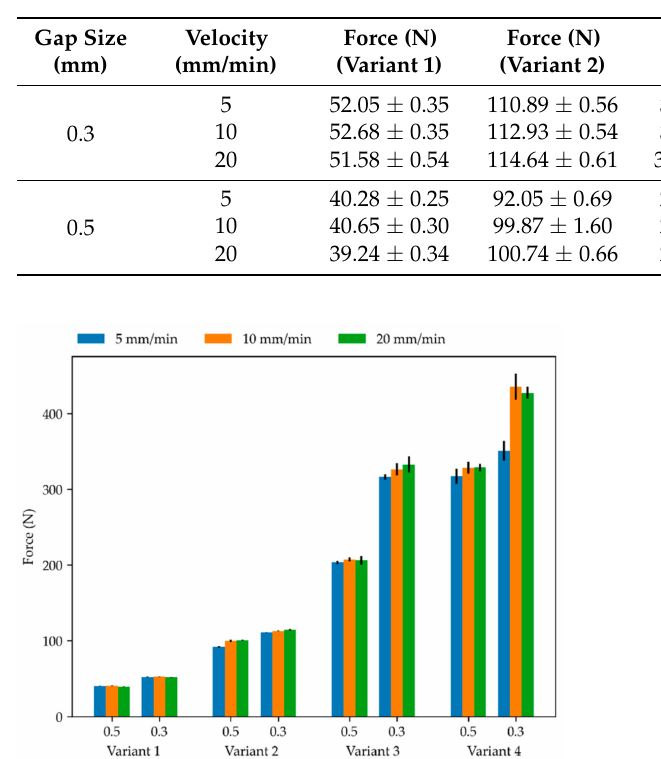
Table 3. Mean peak force and its standard deviation in newtons, for each cycle of five actuations.